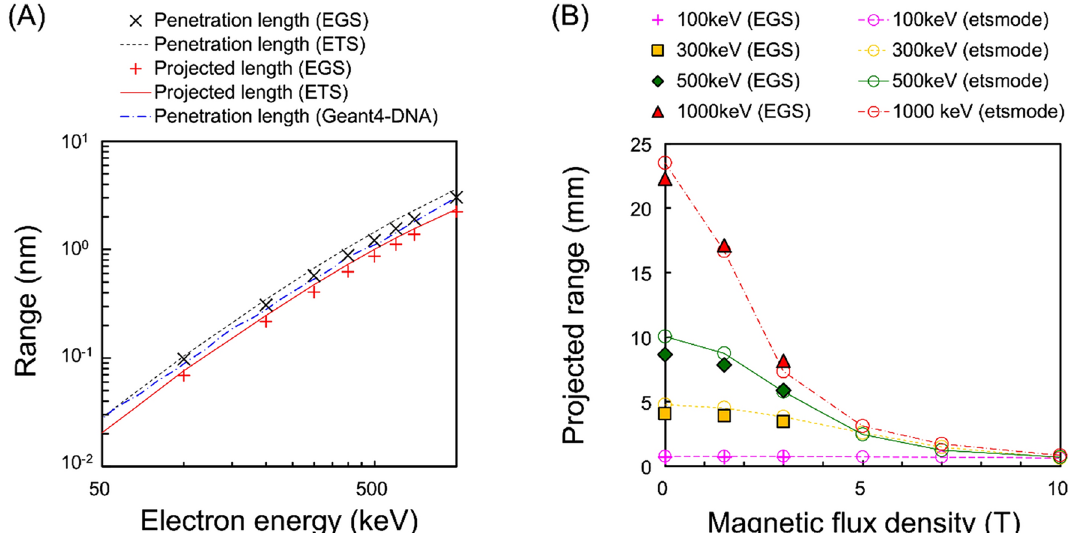
Figure 2. Electron ranges in SMFs calculated by etsmode and EGS. ( A ) shows the penetration length and projected range in the absence of a SMF ( B = 0.0 T) and ( B ) shows the projected range in the presence of various SMF strengths ( B = 0.0–10.0 T). The simulation results by etsmode and EGS are in good agreement with each other and other simulation results by the Geant4-DNA toolkit 30 . As shown in Fig. 2B, the projected range of high-energy electrons is largely affected by the SMF